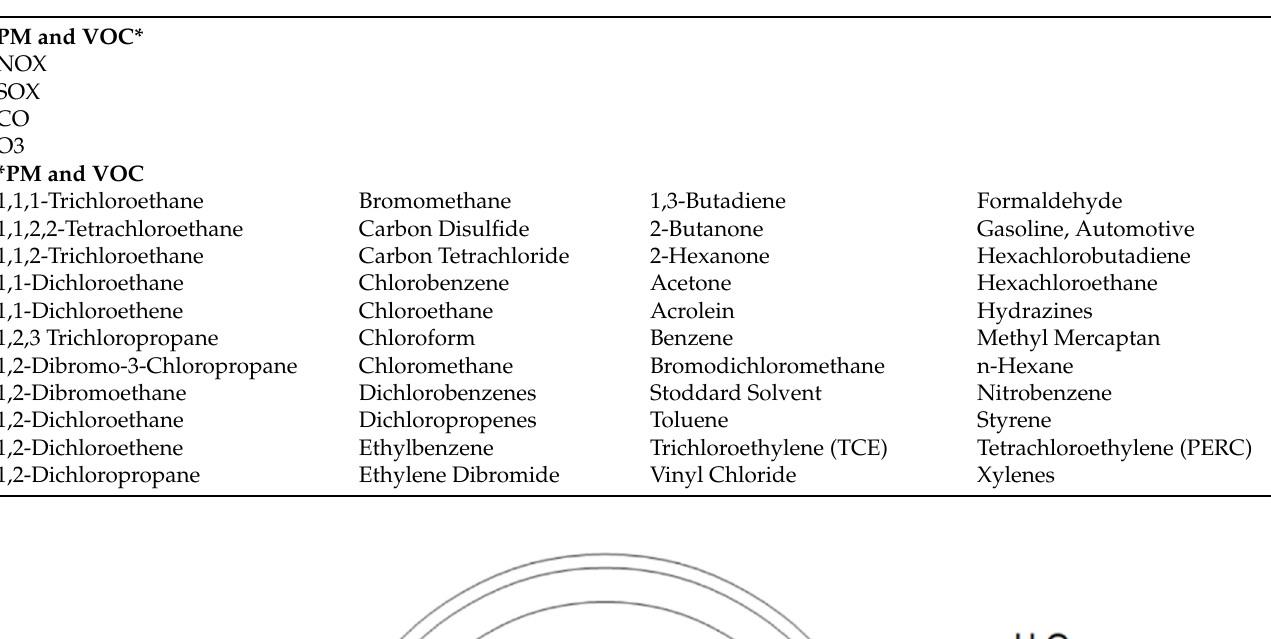
Table 1. PM and VOC contamination.